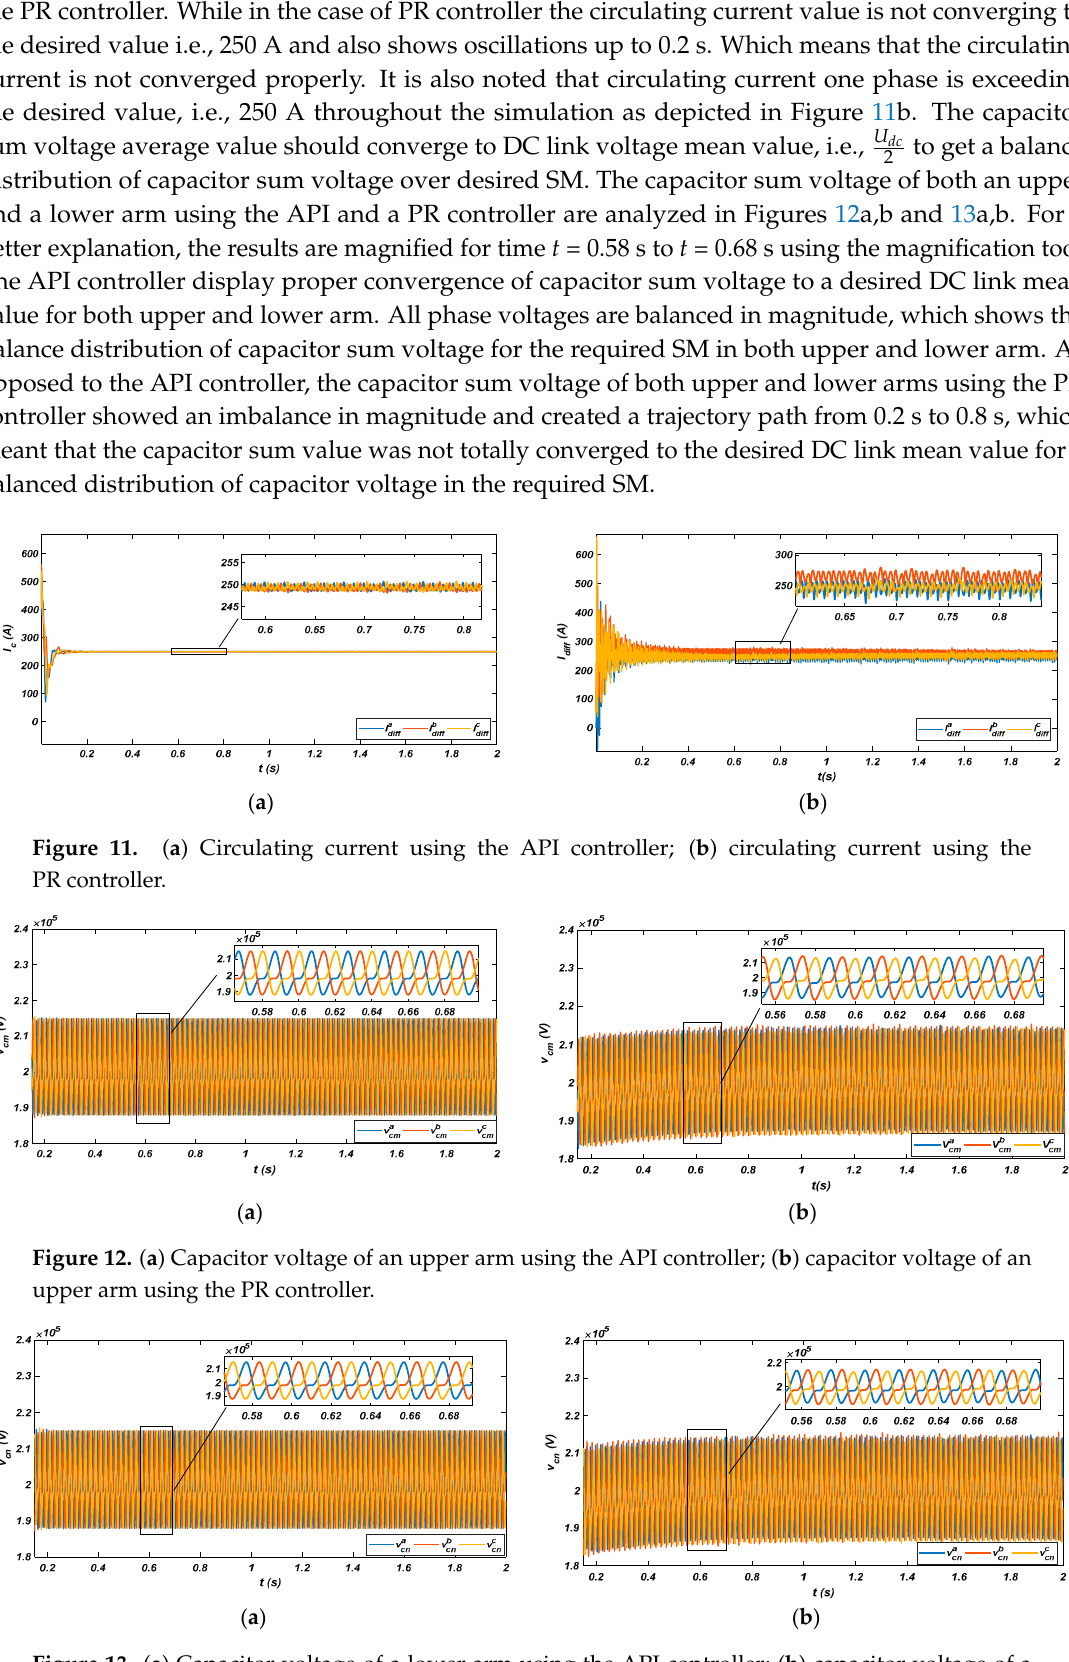
( b ) Figure 14. ( a ) Sum energy of arms using the API controller; ( b ) sum energy of arms using the PR controller.